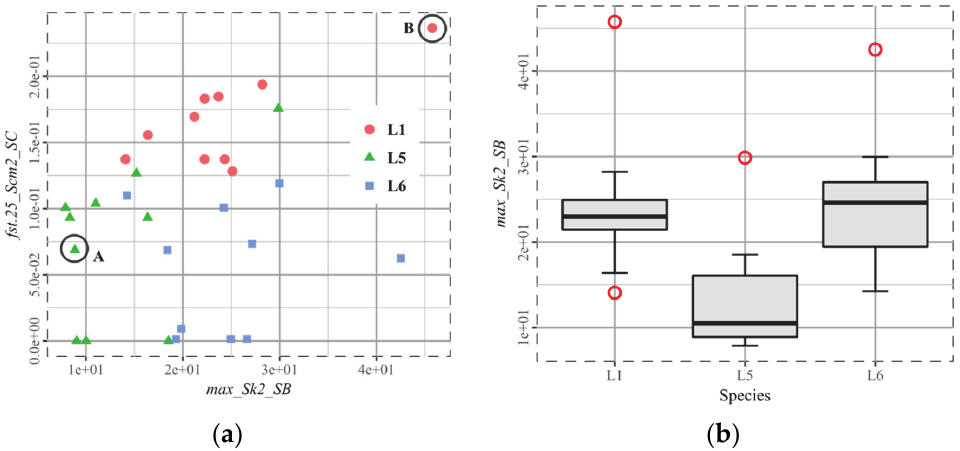
Figure 11 . Ewes fed on ray grass and red clover, most discriminating parameters. ( a ) The topology parameters Sk2 and Scm2 separate L5, L6 and (L5, L6), L1 respectively. The surfaces related to points (A) and (B) are represented in the ESM; and, ( b ) max_Sk2_SB is statistically higher for L1 than for L5.